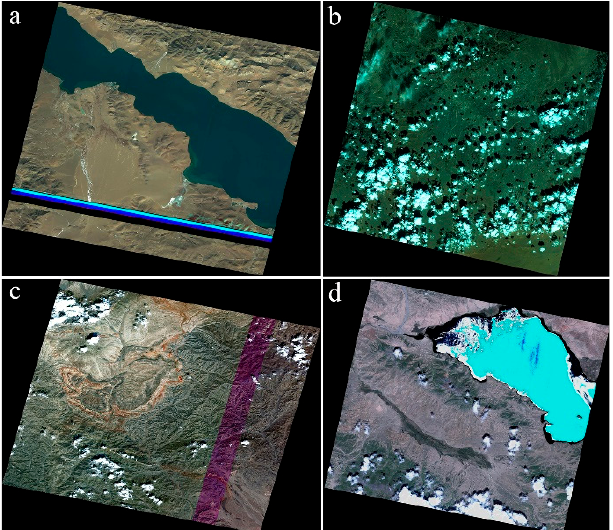
Figure 1. Examples of abnormal satellite images: ( a ) narrow-stripe data missing, ( b ) green color cast, ( c ) stripe with abnormal color, ( d ) pixels with extreme color. Best viewed in color.